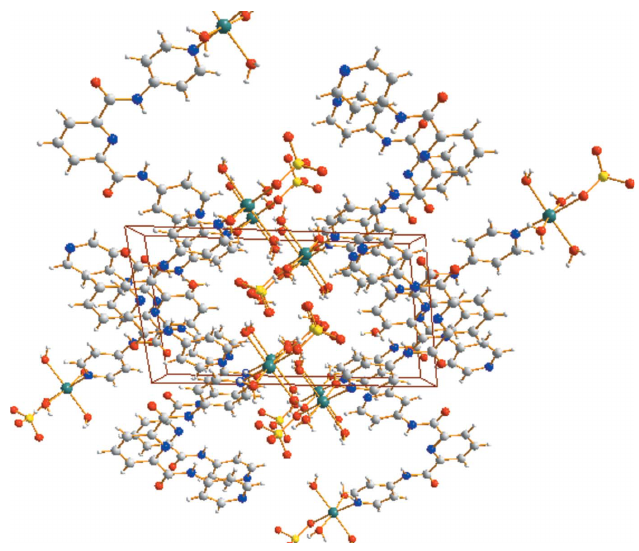
Figure 4 The molecular packing of (I) viewed along the a axis. In complexes (I) and (II), the heterocyclic nitrogen ligand L 1 ) acts as a monodentate ligand. The results indicate that (H 2 the rational design and selection of ligands with heterocyclic nitrogen systems is an effective synthetic strategy to construct complexes via self-assembly. The asymmetry of the [ N , N 0 - bis(pyridin-4-yl)pyridine-2,6-dicarboxamide ligand has resulted in some novel structures. Further study is ongoing.